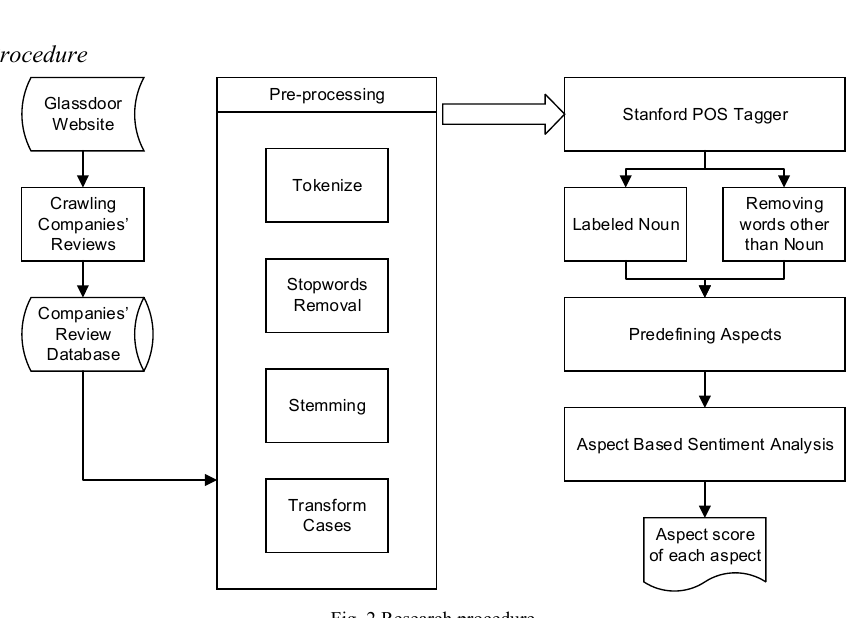
Fig. 1 Glassdoor.com